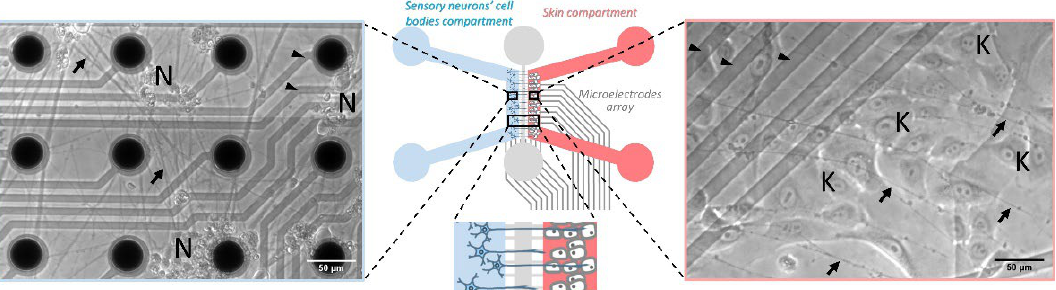
Figure 1. Development of an innervated skin-on-chip. In the center, the micro-fluidic device architecture, with on the bottom, a close-up view of three compartments. On the left side, a representative transmission light pictures of the compartmentalized culture of human iPSC-derived sensory neurons (N). On the right side, a representative transmission light pictures of the compartmentalized culture of human primary keratinocytes (K) with neurites (arrows) which grow from one channel to the opposite one. The culture was done on a micro-electrode array (arrow heads) allowing electrophysiological recording of the neuronal activity.